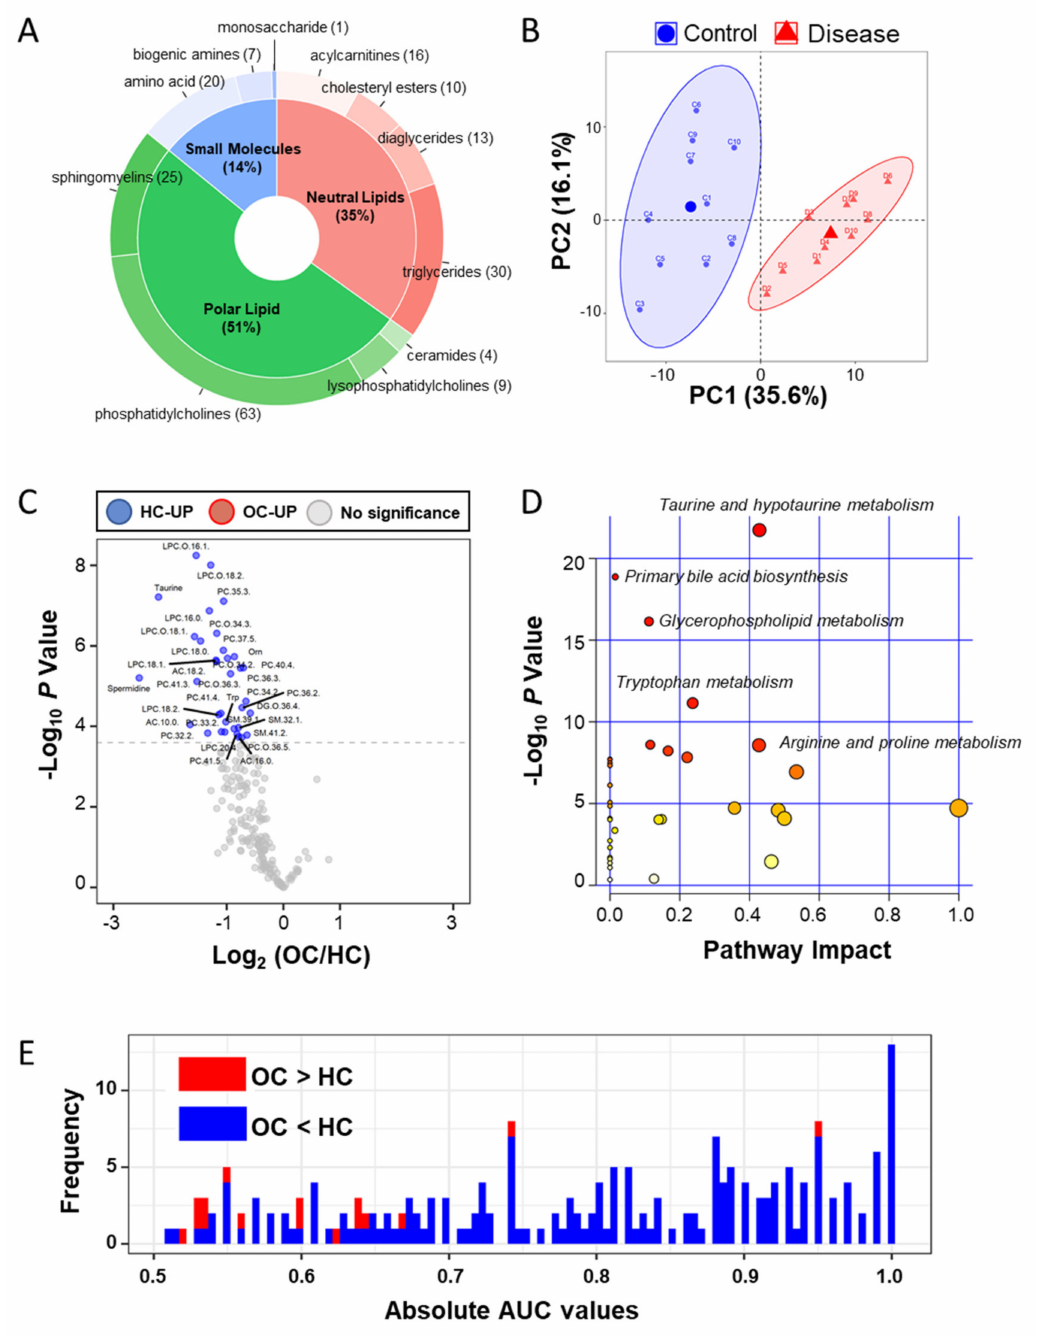
Figure 1. Targeted metabolic analysis by mass spectrometry in the clinical plasma samples. ( A ) Donut plot of 199 quantified metabolites in the AbsoluteIDQ p400 kits; ( B ) PCA analysis result of plasma metabolites in 20 clinical samples; ( C ) volcano plot of plasma metabolic data; volcano plots are depicted with the fold change of each metabolic amount and the p value was calculated by performing a Student’s t -test. Blue circles are less than a Bonferroni-corrected p -value < 0.05, indicating a significantly increased 34 metabolites in HC. Gray circles are plasma metabolites without statistical meaning. ( D ) Pathway enrichment analysis in the MetaboAnalyst 4.0 tool; the y-axis represents the p value, the x-axis represents the impact value; the top five pathways are represented as text based on the p -value. The color and size of each circle represents p -values and pathway impact values, respectively. ( E ) Histogram of 199 absolute area under curve values in univariate ROC analysis. Red bar indicates the high mean value in ovarian cancer and the blue bar indicates the low mean